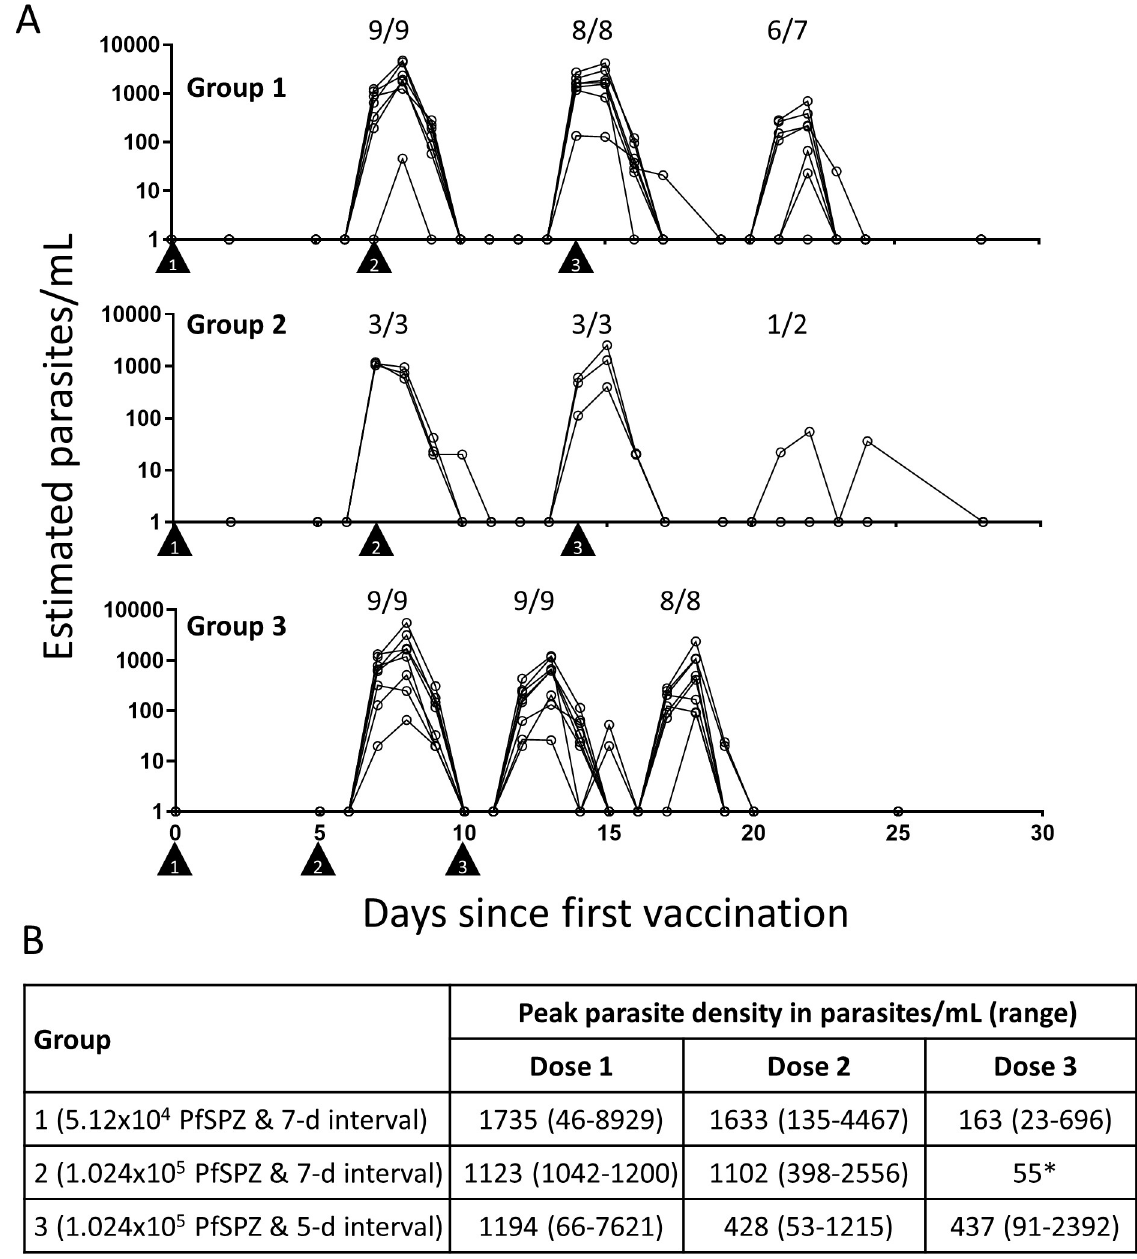
Fig 3. Parasite density estimated by qRT-PCR in vaccinated subjects after each vaccination by group. (A) Triangle symbols indicate the first, second, and third days of vaccine administration as shown. The numbers above each peak of parasitemia display the number of persons positive divided by the total number of vaccine recipients for that dose of vaccine. Days are listed relative to the first dose of vaccine. The number of participants completing each vaccination are listed above each peak of parasitemia. Group 1 received a PfSPZ Challenge dose of 5.12x10 4 PfSPZ for each of three doses given by DVI seven days apart. Group 2 received a PfSPZ Challenge dose of 1.024x10 5 PfSPZ for each of three doses given by DVI seven days apart. Group 3 received a PfSPZ Challenge dose of 1.024x10 5 PfSPZ for each of three doses given by DVI five days apart. (B) Inset table indicates the geometric mean peak parasite density and the minimum/maximum ranges for each post- vaccination interval in estimated parasites/mL. � The value for the single subject with parasitemia.